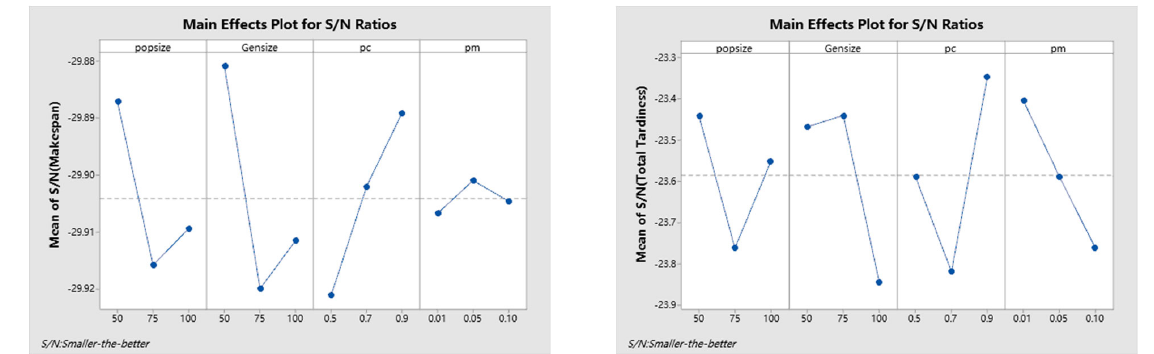
Fig. 5. The mean S/N results for the bi-objective of makespan and TT of small-scale problems